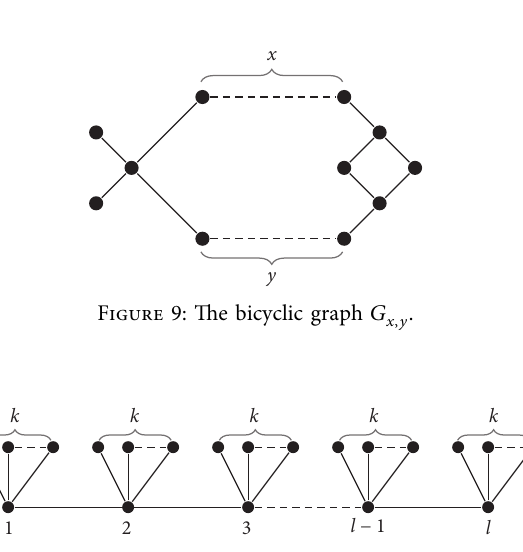
Figure 10: The caterpillar tree T k